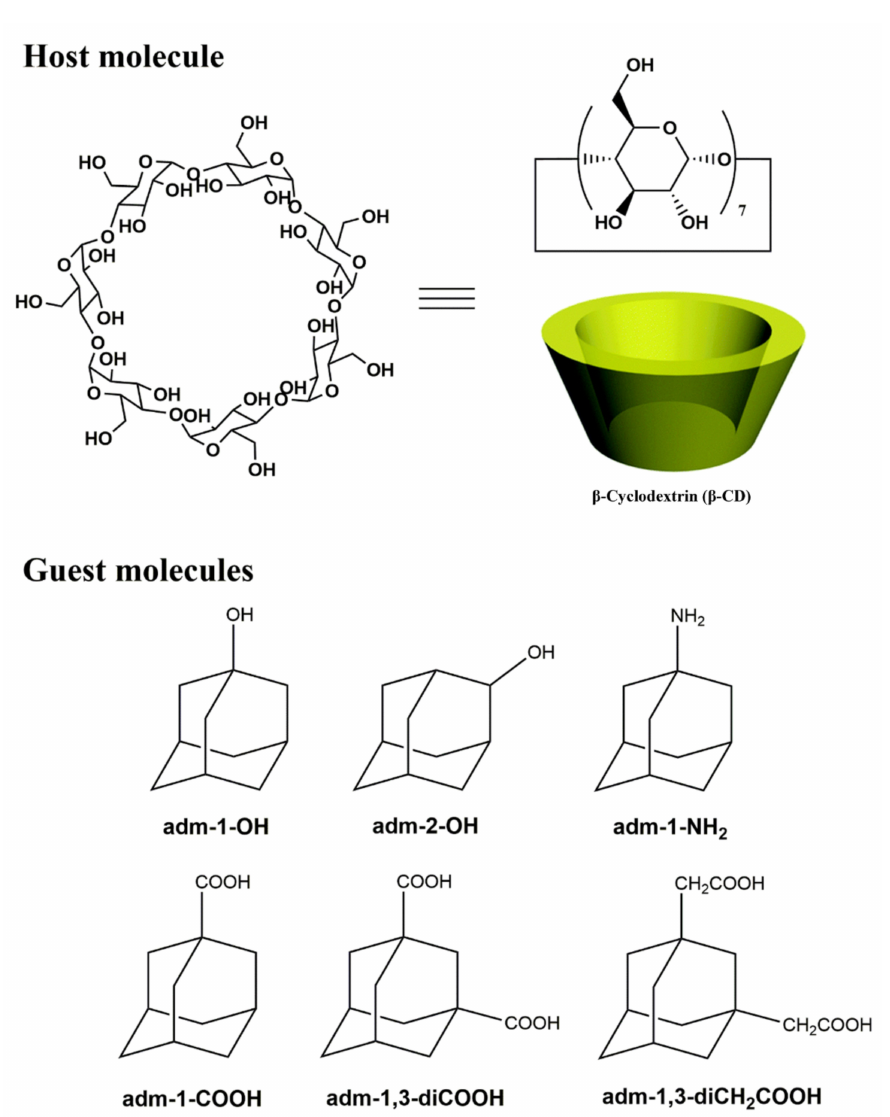
Chart 1. Chemical structures and cartoon illustration of β -CD and the adamantane